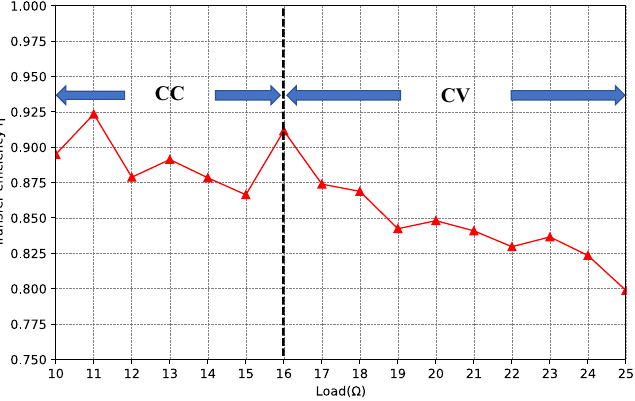
Figure 15. Transmission efficiency.